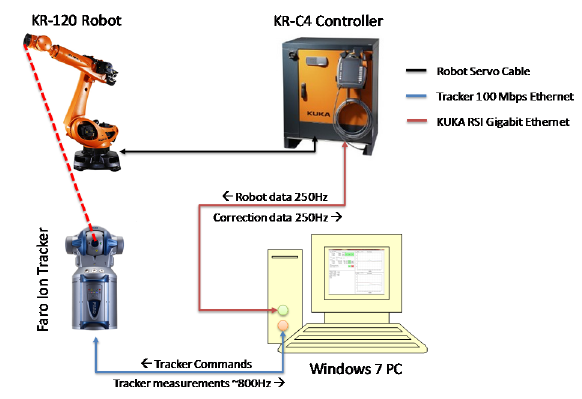
Figure 7. Hardware and data flow.